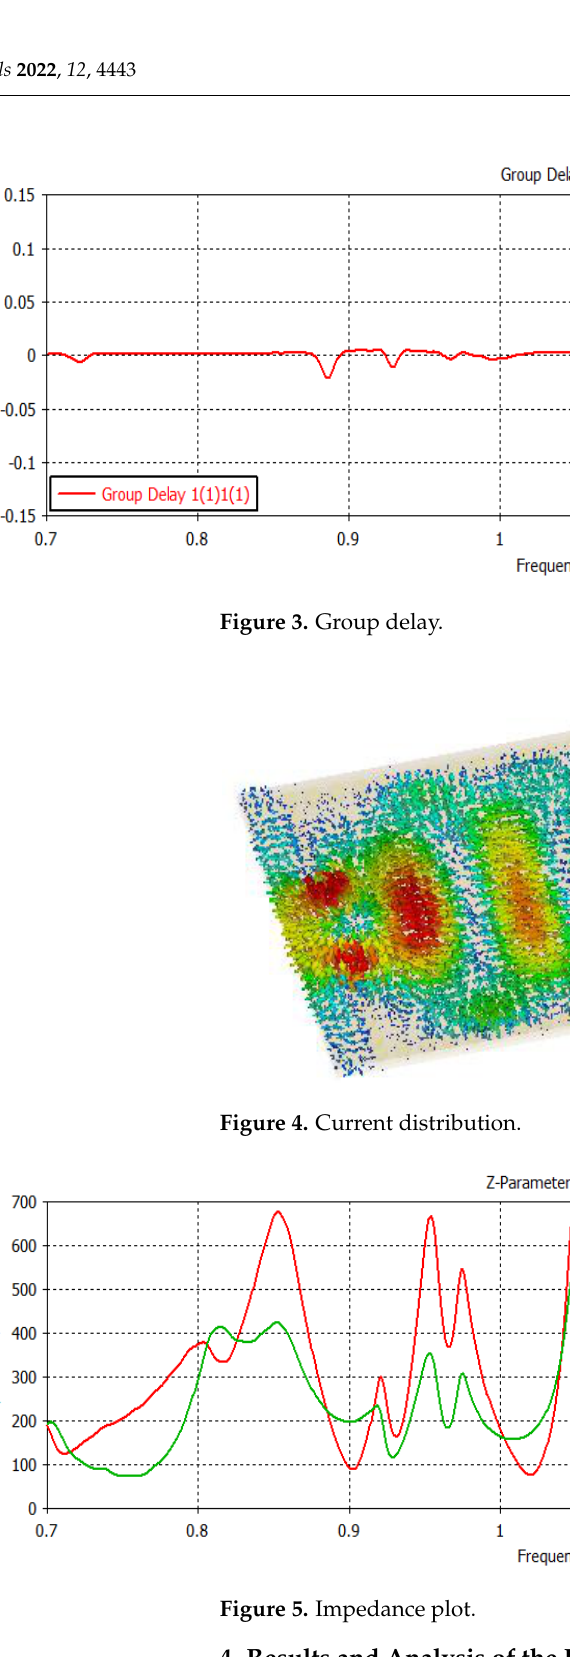
Figure 6. Chemical potential = 0.1 eV. Figure 7. Chemical potential = 0.2.